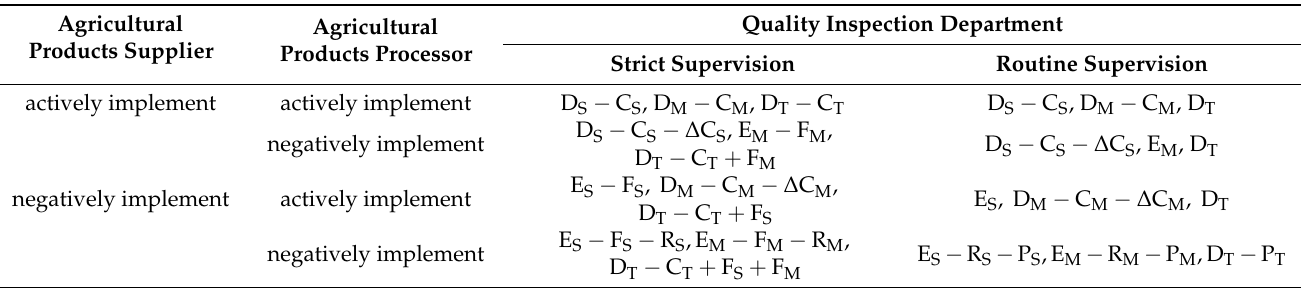
Table 1. Strategic income matrix of three stakeholders in agricultural product supply